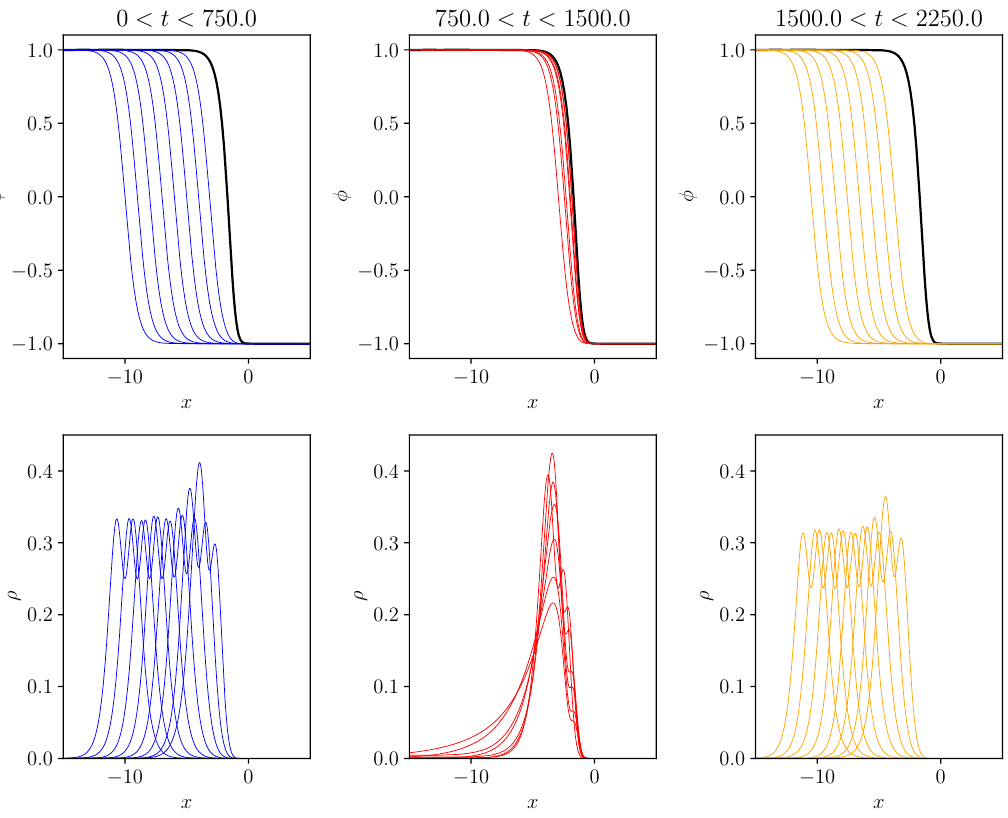
Figure 5 . Several snapshots of the scalar field φ and fermion number density ρ as the antikink approaches the spectral wall. The antikink is reflected by the wall for β = 44 . 0